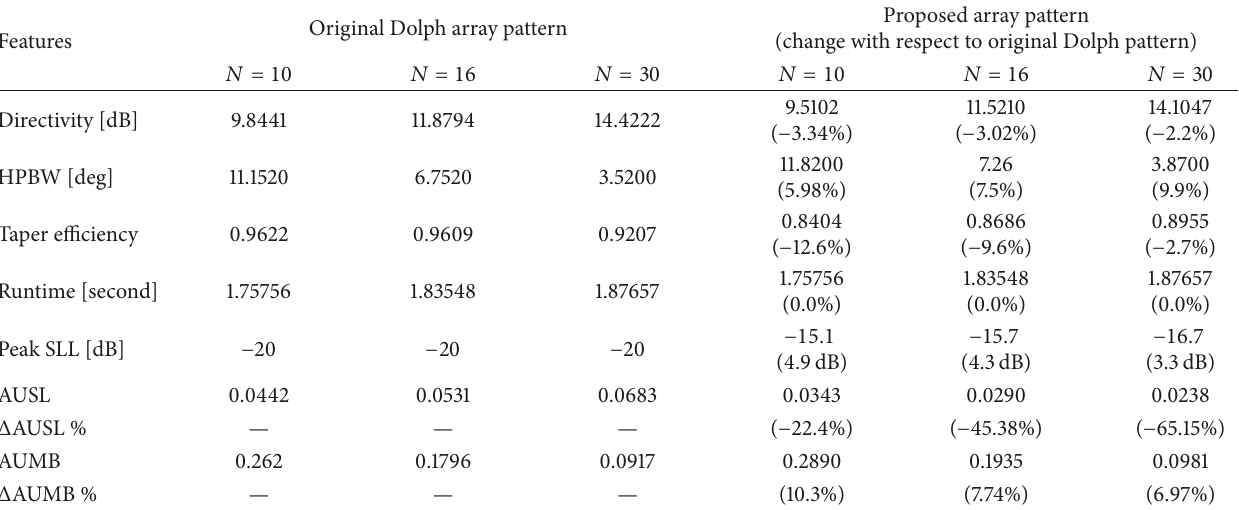
Table 1: Patterns features for different number of array elements 𝑁 and 𝑑 = 𝜆/2 .